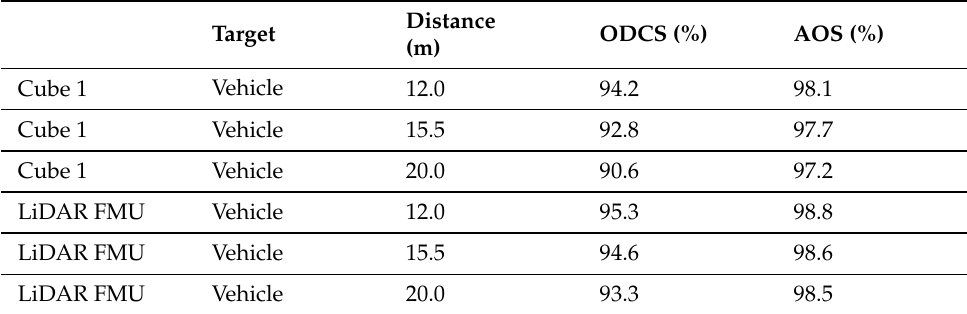
Table 7. Results of the object detection algorithm for simulated and real data.